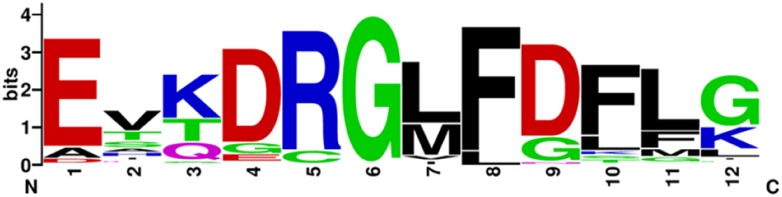
Logo representation of the F-segment discovered with MEME.The logo representation was generated using WebLogo [60]. The first three residues of the F-segment discovered in MEME were not very conserved, and were therefore removed for this representation. Colors represent each amino acid group: Black for hydrophobic (Ala, Ile, Leu, Met, Phe, Pro, Trp, Val), green for polar (Cys, Gly, Ser, Thr, Tyr), purple for neutral (Asn, Gln), red for negatively charged (Asp, Glu), and blue for positively charged (Lys, Arg, His).